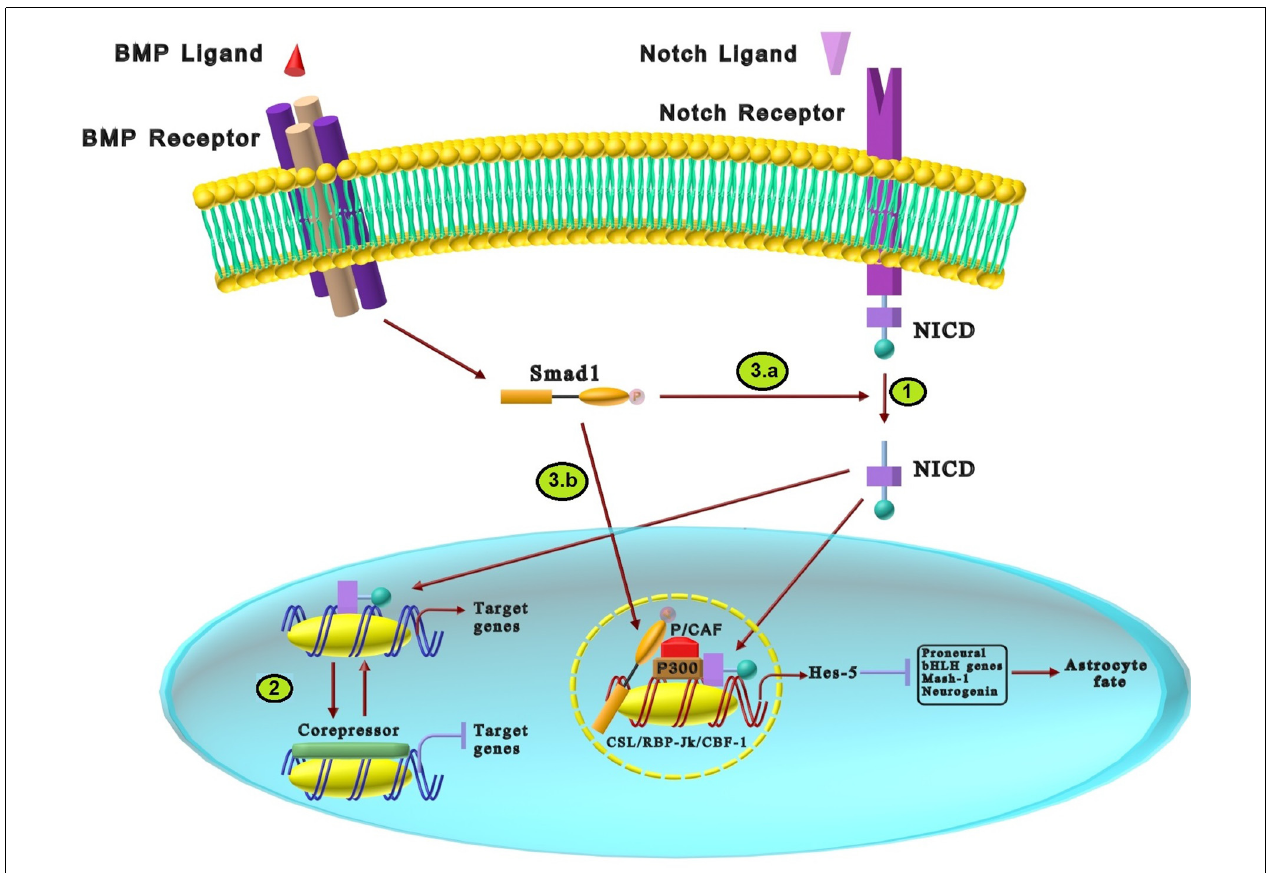
FIGURE 4 | The cross-talk between BMP and Notch signaling pathways in neural differentiation. (1) The interaction of Notch ligands and single-pass transmembrane receptors results in the proteolytic breakdown and release of the NICD. Translocation of NICD into cell nucleus activates the CSL/RBP-Jk/CBF-1 transcription complex that increases the expression of Notch target genes. (2) In the absence of NICD, the co-repressor binds to the CSL transcription factor and inhibits the transcription of target genes, while the interaction of NICD with CSL promotes the transcription of target genes. (3) The cross-talk between BMP and Notch signaling in astrocytes differentiation is mediated via two distinctive ways: (a) BMP2 stimulation activates Smad1 that promotes the recruiting of NICD intracellular domain. Activated NICD increases activation of the Hes-5 gene promoter. (3.b) BMP2 promotes Smad1 to interact efficiently with NICD in presence of p300 and P/CAF that forms a transcription complex. This complex upregulates Hes-5, which inhibits proneural bHLH transcription factors such as Mash-1 and neurogenin and increases astrocyte